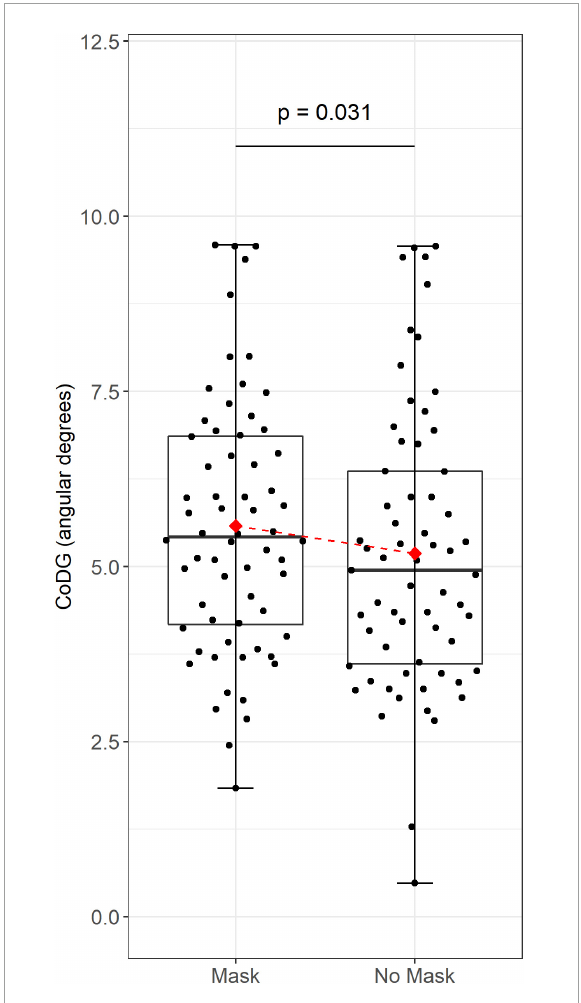
FIGURE2 Data are plotted as box plots for each condition (“mask” and “no mask”). Bold horizontal lines indicate median values, boxes indicate 25/75% interquartile range, and whiskers indicate 1.5 × interquartile range. Red diamonds indicate the mean cone of direct gaze (CoDG) in the “mask” and “no mask” condition. Red line connects mean CoDG in “mask” and “no mask” condition. Individual CoDG are shown separately as black dots, jittered proportionally to the density (jittered density